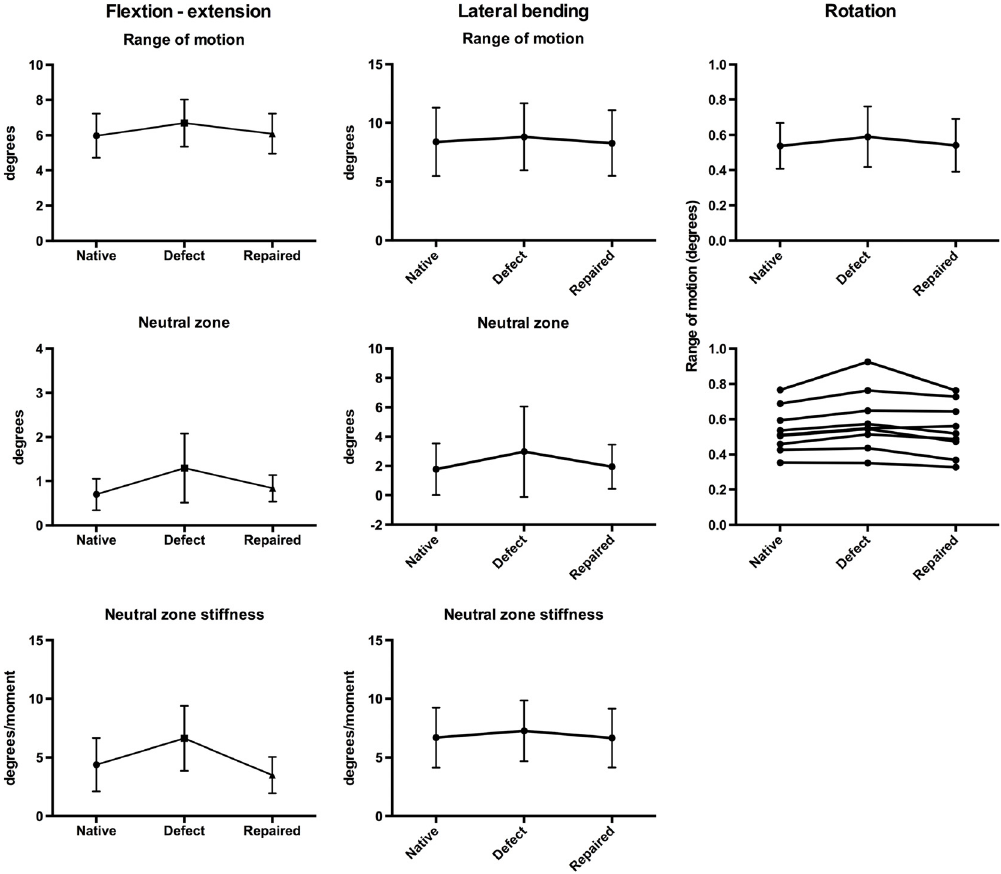
Figure 5. Graphs showing results of the 3 movements, fl exion – extension, lateral bending and rotation. Means shown with standard deviations. Range of motion was increased when inducing a defect in AF and decreased when closing the defect, p < 0.0003. Neutral zone was also increased when applying the defect and decreased when closing it, but not signi fi cantly. Neutral zone stiffness also an indicator of stability in the motion segment showed deterioration when the AF was injured, but regained when the injury was